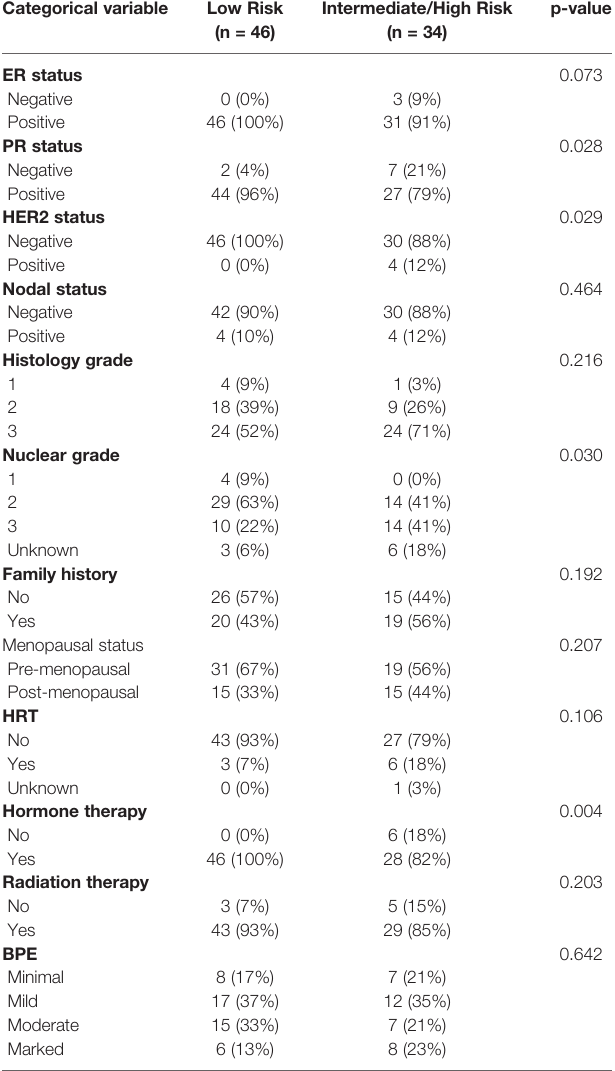
HRT, hormone replacement therapy.